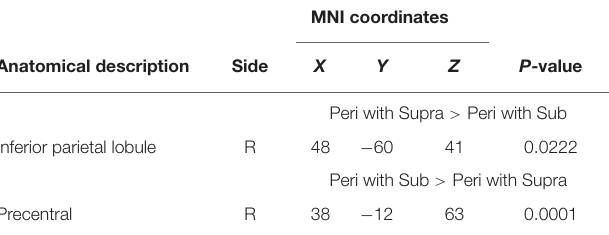
FIGURE 4 | Peri-second trials intermixed with supra-second trials versus peri-second trials intermixed with sub-second trials. The color scales indicate the cluster-wise corrected P-value. TABLE 2 | Brain regions that exhibited context-dependent time